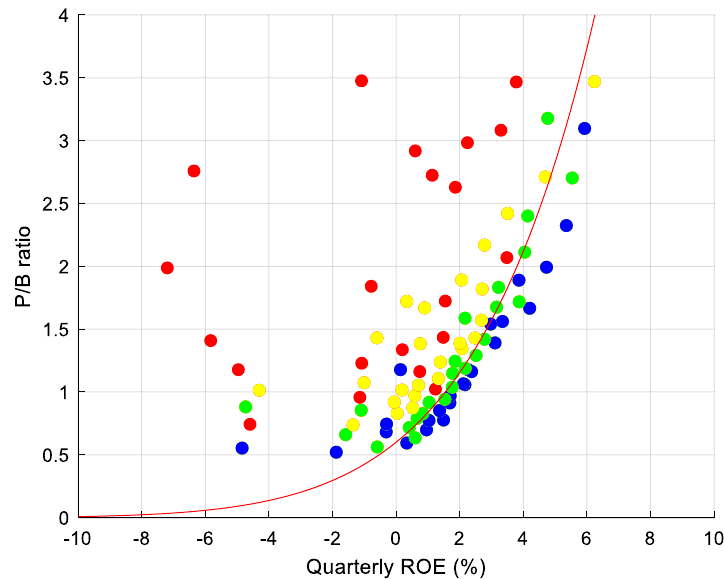
Fig. 32 The relationships among the ROE(t quantile, yellow: 25–50%, green: 50–75%, blue: 75–100%)